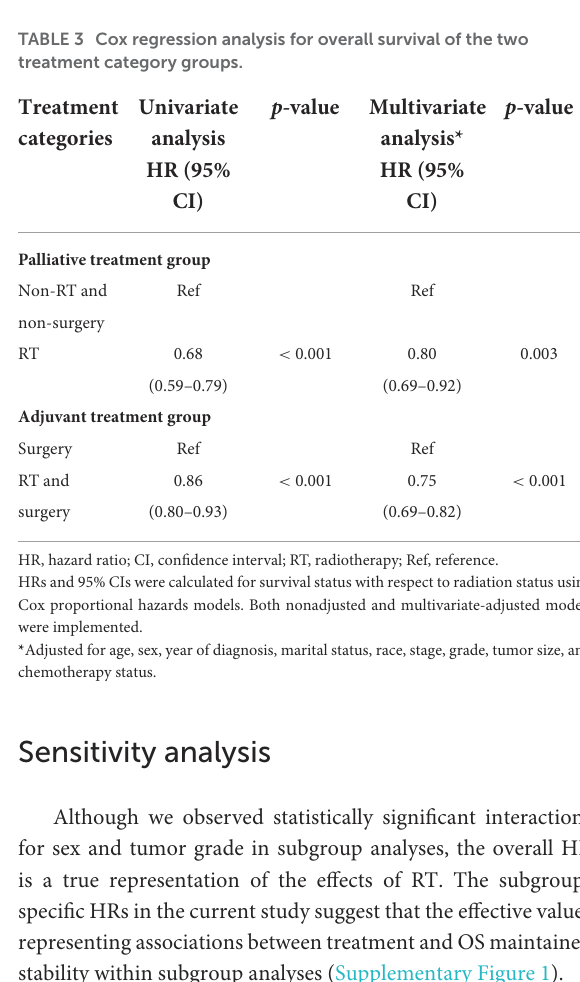
TABLE 2 Univariate and multivariate Cox proportional hazards regression analyses for overall survival.